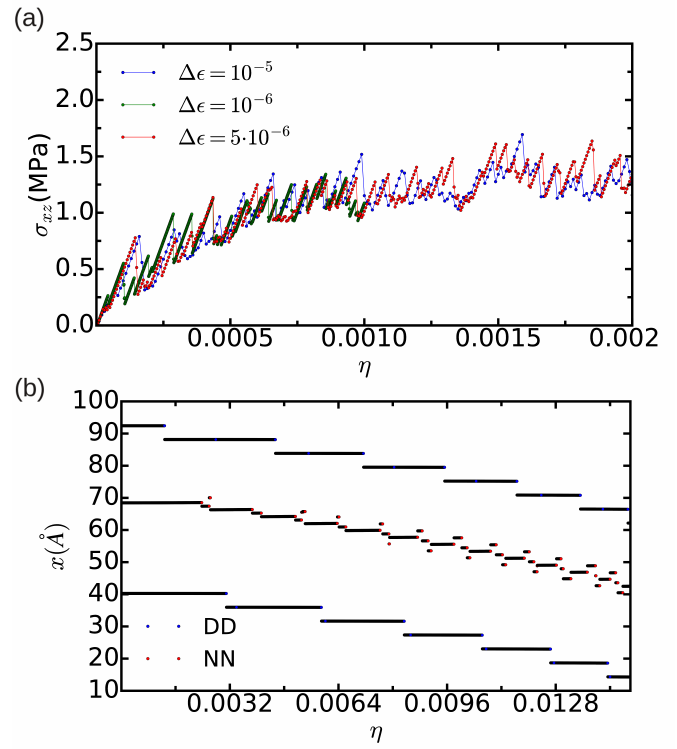
Figure 8. ( a ) evolution of the shear stress expressed as a function of strain for a simulation cell containing n = 18,424 atoms in which the thickness of the “U” part is equal to d U = 2.5 c . Several mechanical strain steps, ∆ (cid:101) , are considered; ( b ) position of the corresponding dissociated edge dislocation expressed as a function of strain. “DD” and “NN” stand for the analysis methods of differential displacement and nearest neighbors,